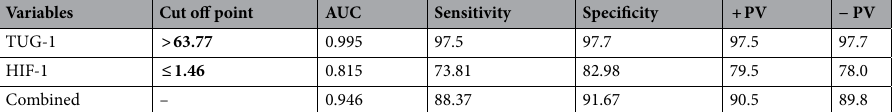
Table 6. ROC table for the best cut off point between sensitive and resistant groups regarding TUG‑1 and HIF‑1α.